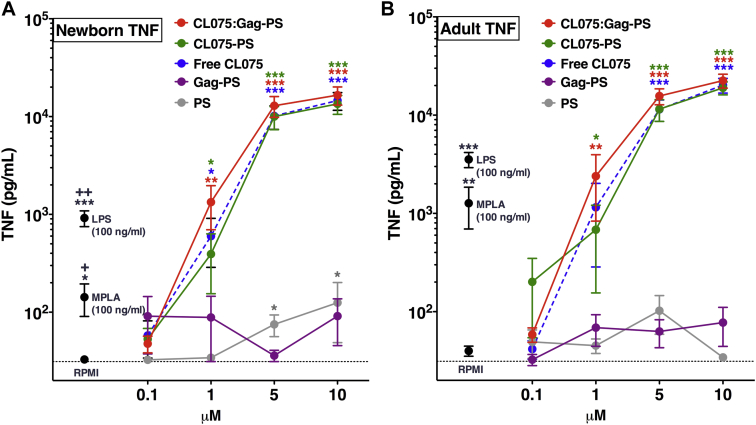
The TLR8 agonist CL075 retains robust TNF-inducing activity toward human newborn and adult MoDCs when encapsulated in polymersome nanoparticles. Human newborn (A) and adult (B) MoDCs were cultured in 10% (vol/vol) autologous plasma and stimulated for 24 hours with fixed concentrations of monophosphoryl lipid A (MPLA) or LPS (100 ng/mL) or increasing concentrations of free CL075 (dashed blue line), CL075-PS (green line), or CL075:Gag-PS (red line; mean ± SEM, n = 8-14). For analyses of individual treatments (eg, control RPMI vs 10 μmol/L CL075), the unpaired Mann-Whitney test was applied at each concentration, and statistical significance was denoted as follows: *P < .05, **P < .01, and ***P < .001. For comparisons between newborn and adult TLR4 agonist–treated conditions (ie, newborn LPS vs adult LPS), significance was denoted as follows: +P < .05 and ++P < .01. See also Fig E6.